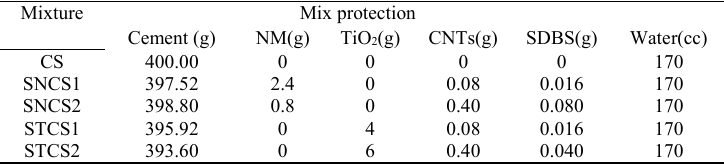
Table 3. Mixture designs of cement paste.